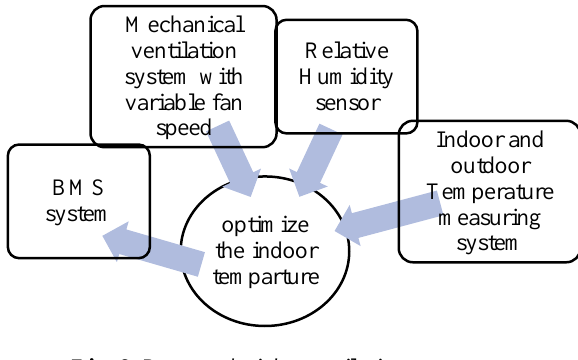
Fig. 6. Proposed night ventilation system